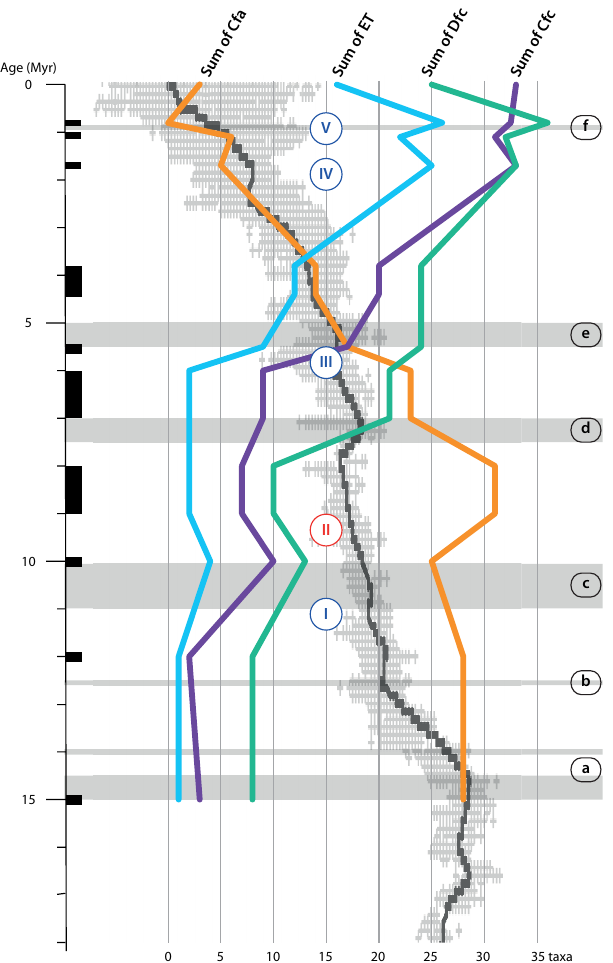
Fig. 5. Climate change over the past 15Myr in Iceland based on Köppen signa- tures of fossil taxa from Iceland (15–0.8Myr rock units, indicated by black bars) and the modern flora of Iceland (monocots excluded) compared to global trends inferred from marine isotope ( δ 18 0) records (grey background curve; Zachos et al., 2001). Cfa climate: warm temperate, fully humid with hot summers; Cfc: warm temperate, fully humid with cool summers; Dfc: snow climate, fully humid with cool summers; ET: polar tundra climate (Köppen, 1936; Kottek et al., 2006). Number of taxa scoring for particular climate types was scaled to 43 for all rock units. (a–f) denote phases of IRD pulses in the Northern Hemisphere: (a) glaciation in the northern Barents Sea region andFramStrait,ODPsite909cat15–14.5Myr(KniesandGaina,2008),andat14Myr in the Fram Strait, ODP sites 908, 909 (Wolf-Welling et al., 1996; Thiede et al., 1998); (b) glaciation at 12.6Myr on the Vöring Plateau, ODP sites 642, 643, 644 (Fronval and Jansen, 1996; Thiede et al., 1998); (c) various pulses of increased IRD from Vöring Plateau and Fram Strait beginning at ∼ 11–10Myr (Fronval and Jansen, 1996; Wolf- Welling et al., 1996; Thiede et al., 1998); (d) IRD pulses at 7.5–7Myr off SE Green- land, ODP site 918 (Larsen et al., 1994; St. John and Krissek, 2002), Iceland Plateau, ODP site 907 and Vöring Plateau, ODP sites 642, 643, 644 (Fronval and Jansen, 1996) and Fram Strait, ODP sites 908, 909 (Wolf-Welling et al., 1996; Thiede et al., 1998);